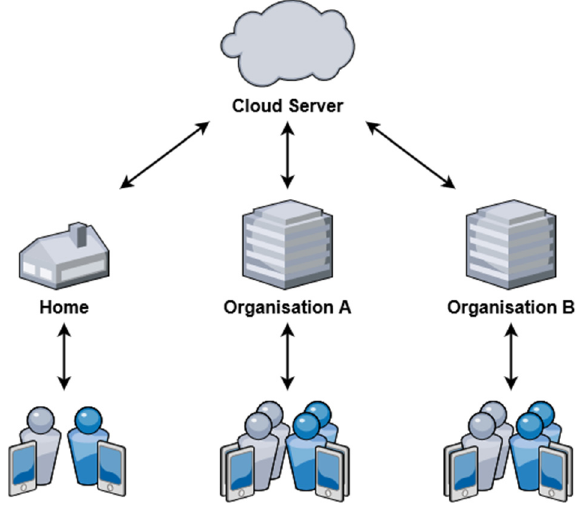
Figure 5. Various end users of a remote monitoring system.